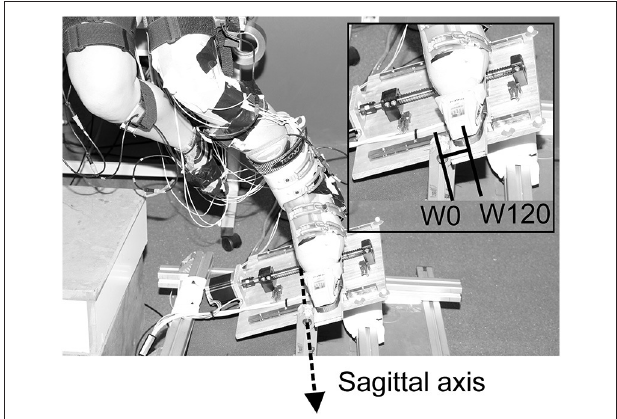
FIGURE 2 | Skiing simulator placed on the force plate. The platform of the simulator was able to freely rotate around the sagittal axis. Two extremes of the four possible ski width positions are represented (W0 represents the position of the sagittal axis beneath the middle of the sole, and W120 represents the simulation of waist width of